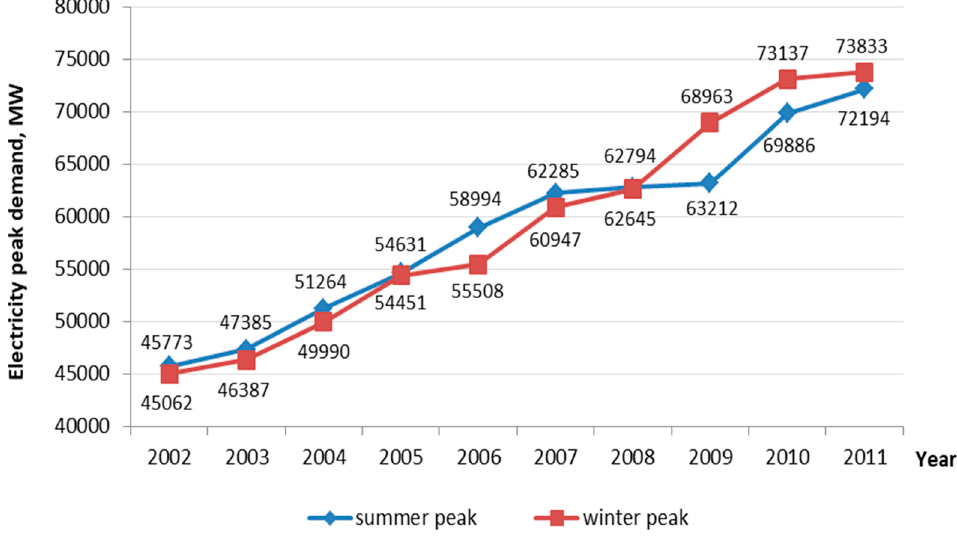
Figure 6. Annual summer and winter peak demands in Korea (source: Ministry of Trade, Industry, and Energy. The Sixth Basic Plan for Long-term Electricity Supply and Demand (2013–2027)).